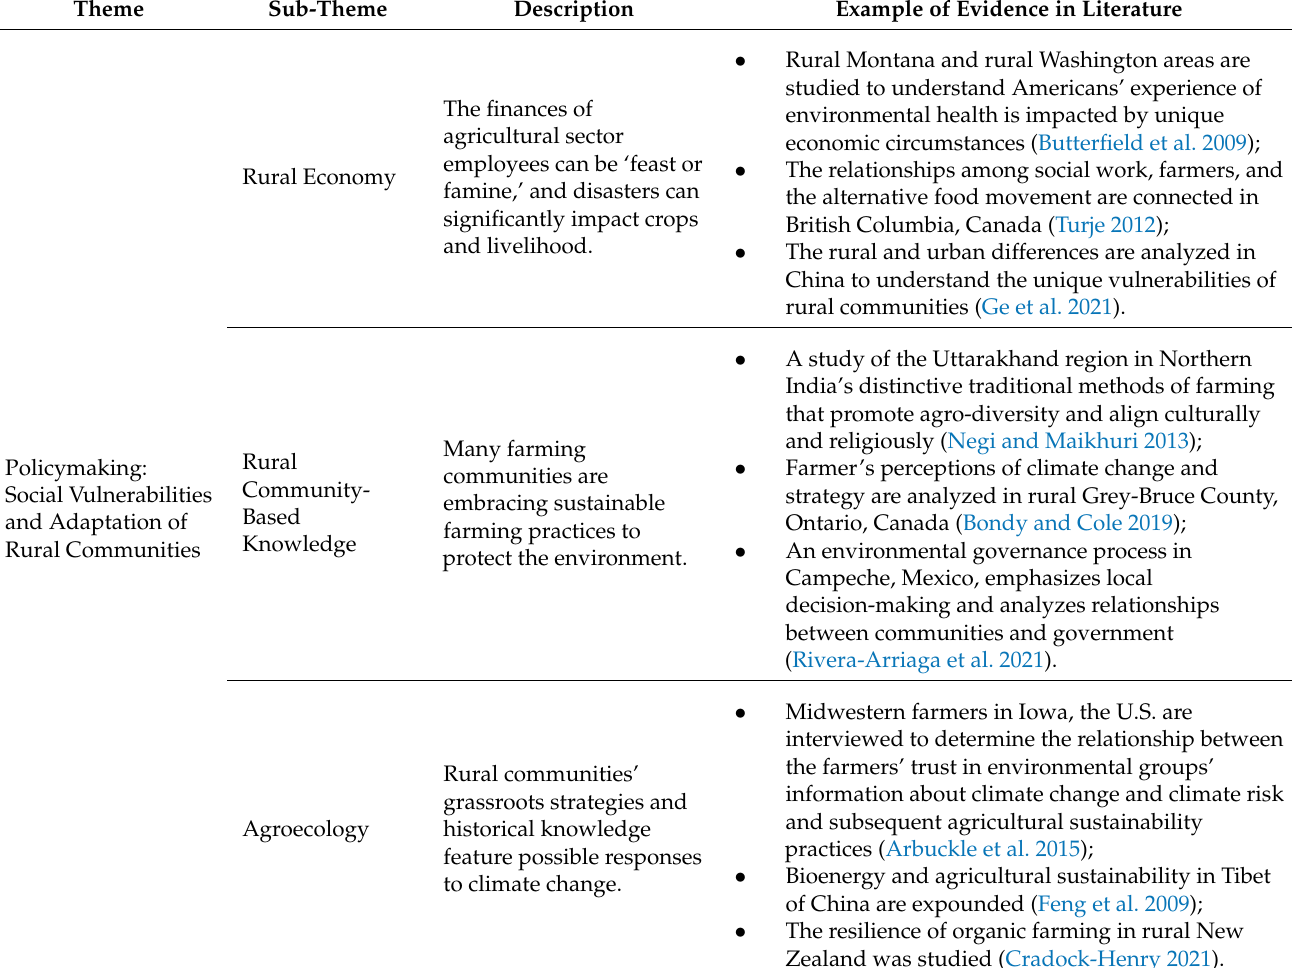
Table 3. General Theme and